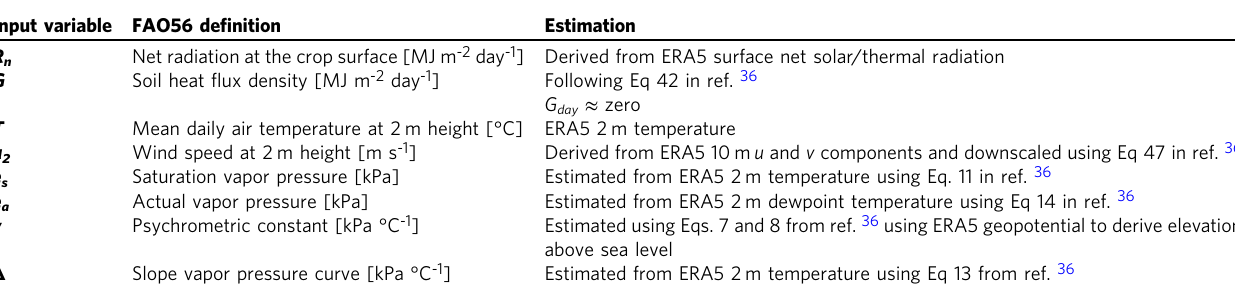
Table 1 PET input variables as estimated from ERA5